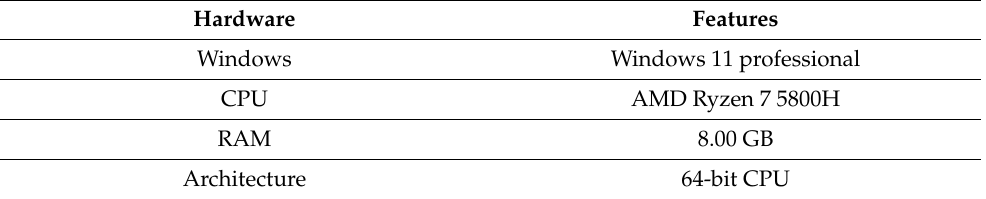
Table 2. Software and Hardware Specifications.